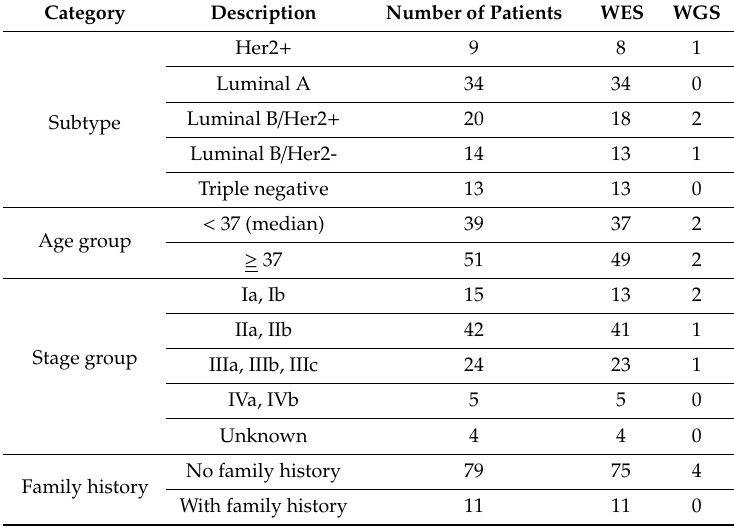
Table 1. Taiwanese early onset breast cancer (EOBC) cohort structure and associated sequencing